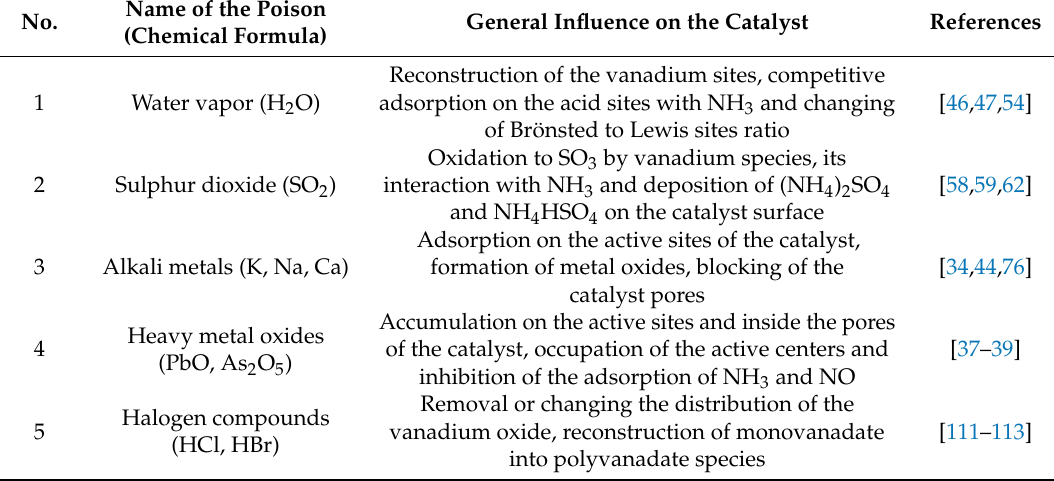
Table 8. Summary of the contaminations of V 2 O 5 -TiO 2 NH 3 -SCR catalyst and their influence on the